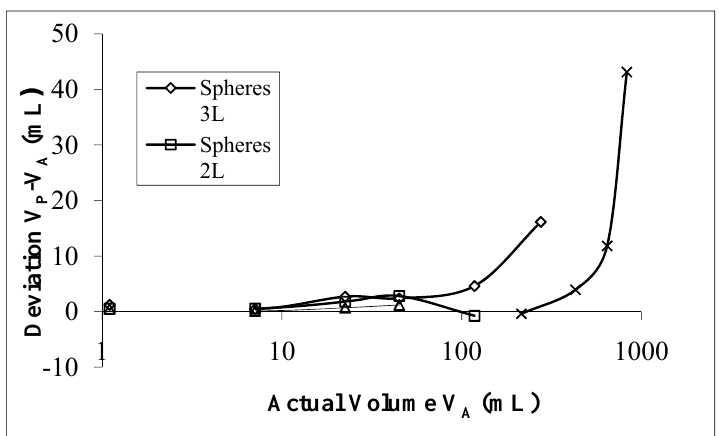
Figure 7. Deviation volume from actual volume for spheres when measured using 1 L, 2 L and 3 L chamber, 170 mm long, and 44 mm diameter